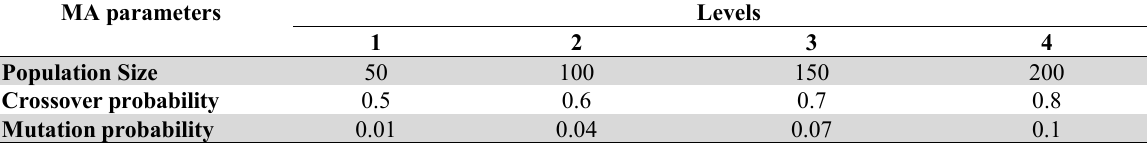
Different levels of MA parameters used for tuning